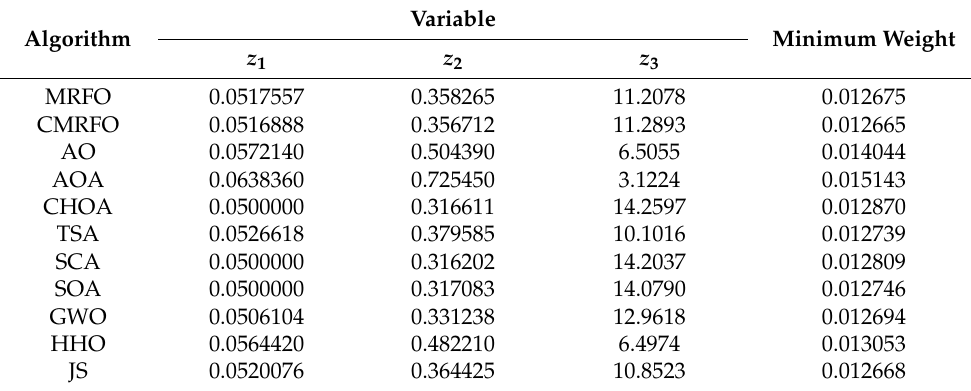
Table 12. Results of all 11 algorithms.